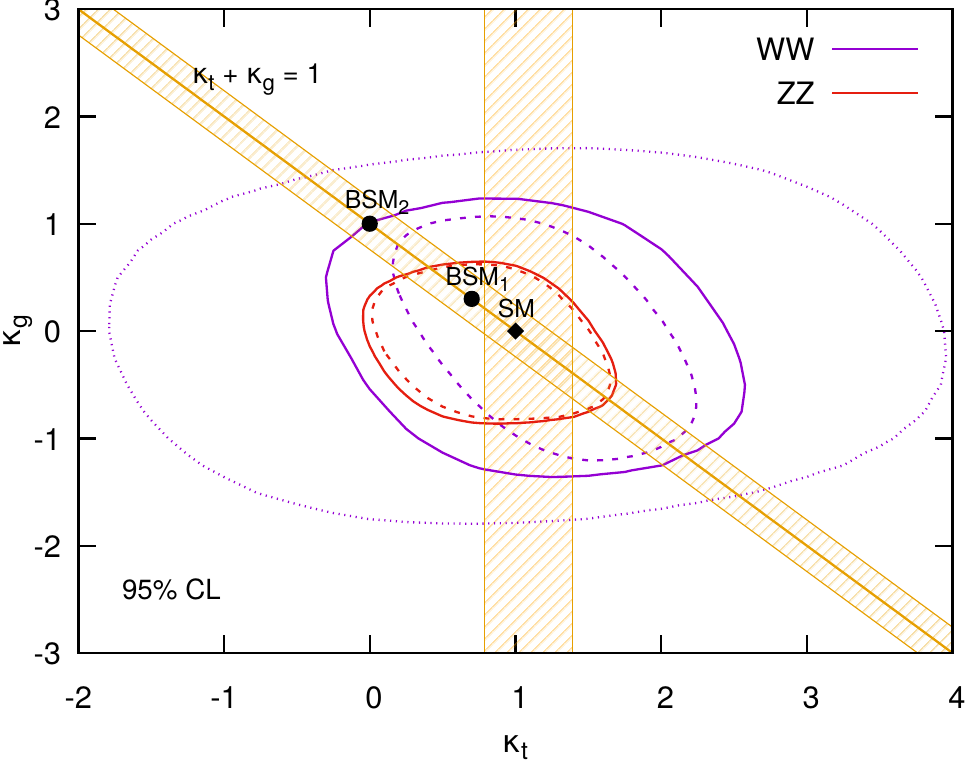
Figure 13 . Exclusion contours at 95% level for WW and ZZ production, corresponding to di(cid:11)erent ways of estimating theoretical uncertainties, see the main text for